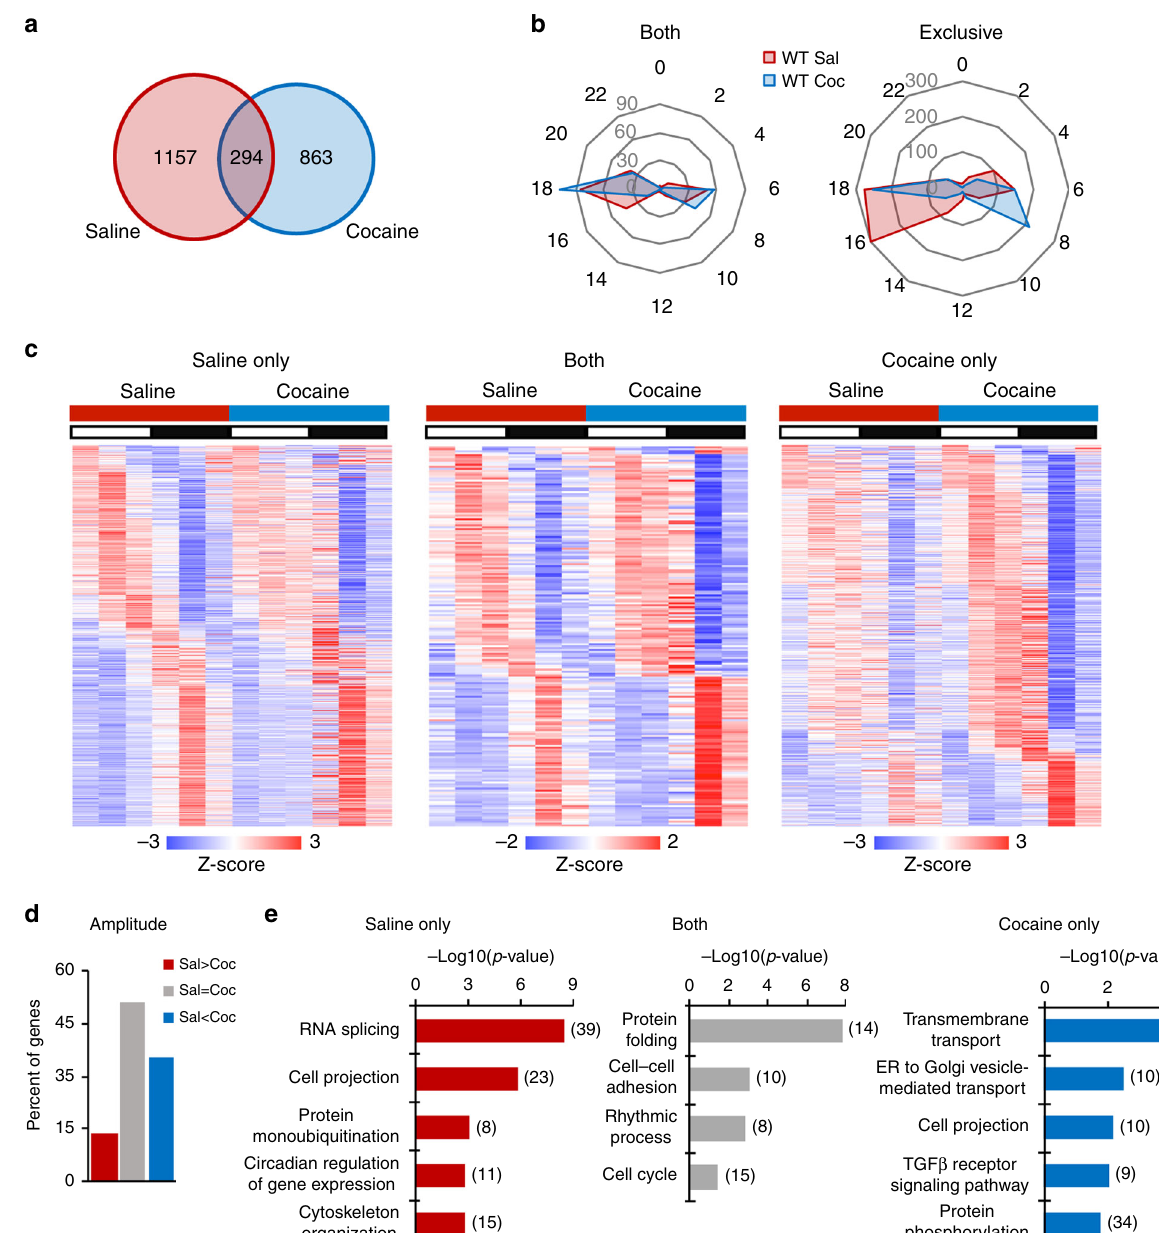
Fig. 2 Cocaine rewires the striatal circadian transcriptome in WT mice. a Venn diagram representing the striatal rhythmic genes in saline and cocaine treated WT mice ( n = 3, JTK_Cycle, cutoff p < 0.01). b Radar plots representing the phase analysis of genes whose expression is circadian in both saline (Sal) and cocaine (Coc) treated mice (left) and genes exclusively circadian in saline or cocaine conditions (right). c , Heat maps representing genes signi fi cantly circadian ( n = 3, JTK_cycle, cutoff p < 0.01) in saline- (left), in cocaine-treated mice (right) and commonly circadian in saline and cocaine treated mice (middle). White and black bars indicate the light (ZT3, 7, 11) and dark (ZT15, 19, 23) timepoints respectively. d Amplitude analysis of striatal transcripts rhythmic in both saline (Sal) and cocaine (Coc) injected mice. The percentage of genes with amplitude higher, lower or equal to saline condition is reported. e DAVID Gene Ontology Biological Process analysis of circadian genes oscillating in saline only (left), both (middle) and cocaine only (right). Bar charts represent the -Log10( p -value) of each enriched term. The number of genes identi fi ed in each pathway is shown in